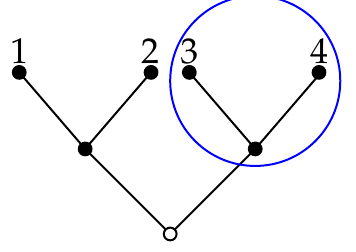
i (cid:44) −! A 2 fixes the circled